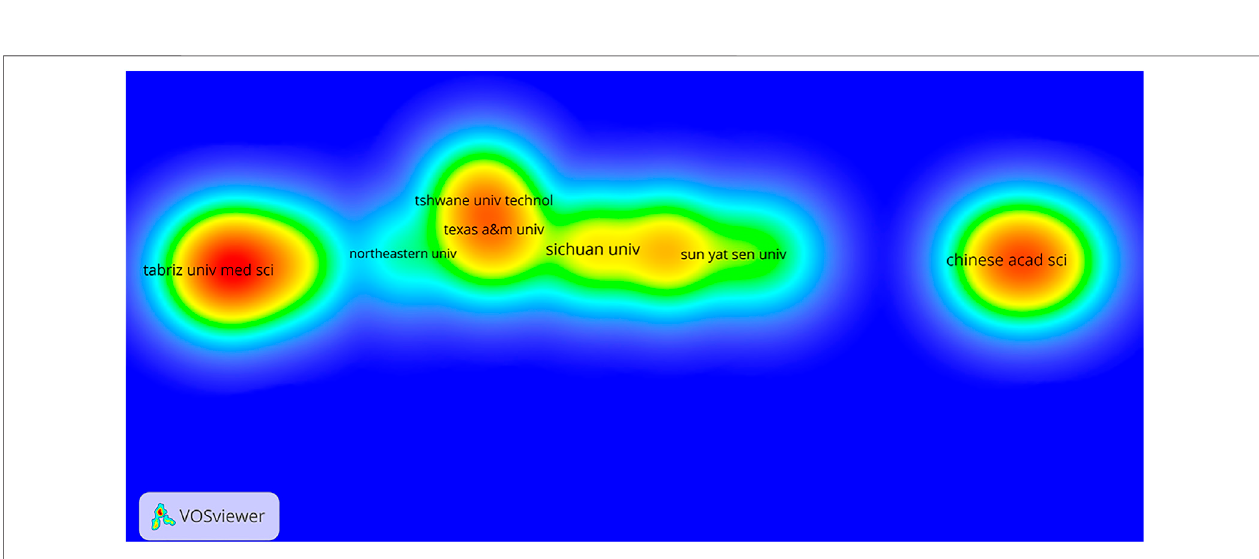
Frontiers in Bioengineering and Biotechnology |